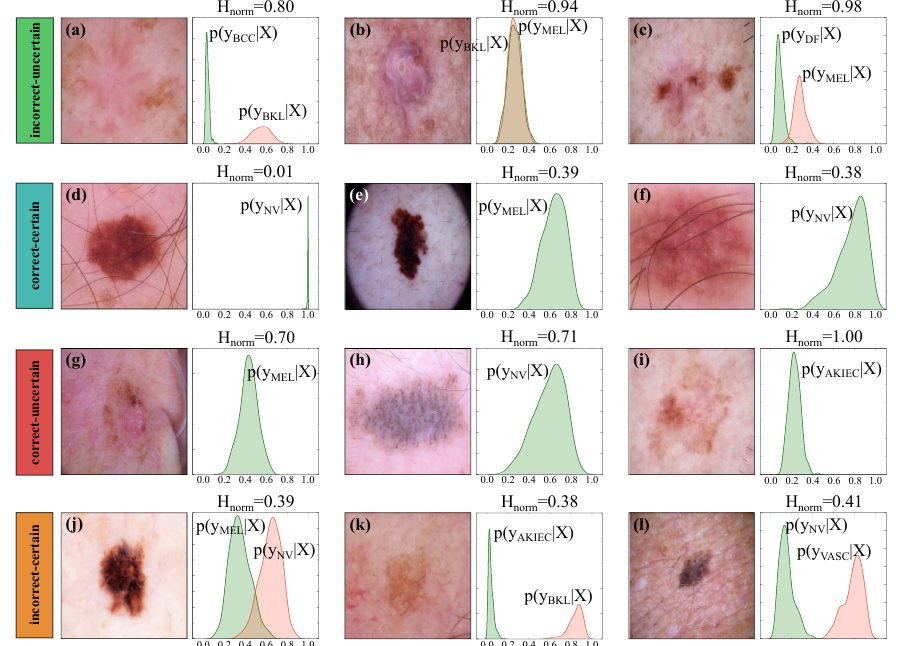
Figure 5. Illustrating sample output posterior distributions and the corresponding uncertainty estimates using the Bayesian DenseNet-169. The Bayesian inference outputs a posterior distribution ( p ( y | X ) ) per class where X represents the input image. We present the posterior distribution of the correct (in green) and incorrect (in red) classes. Predictions are grouped into incorrect–uncertain ( a – c ), correct–certain ( d – f ), correct–uncertain ( g – i ), and incorrect–certain ( j – l ) categories at threshold H T = 0.5. Note that Kernel density estimation with a Gaussian kernel is used to plot the output posterior distributions, for which the bandwidth was chosen according to Scott’s method